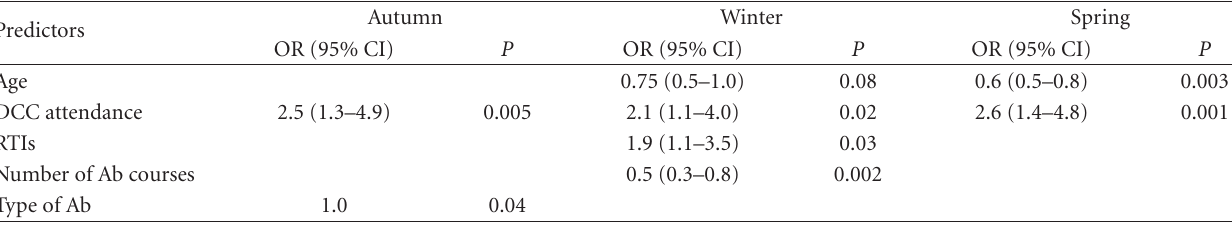
Table 2: Multivariate analysis of predictors of upper respiratory colonization of S. pneumonia in healthy preschool children in following seasons.